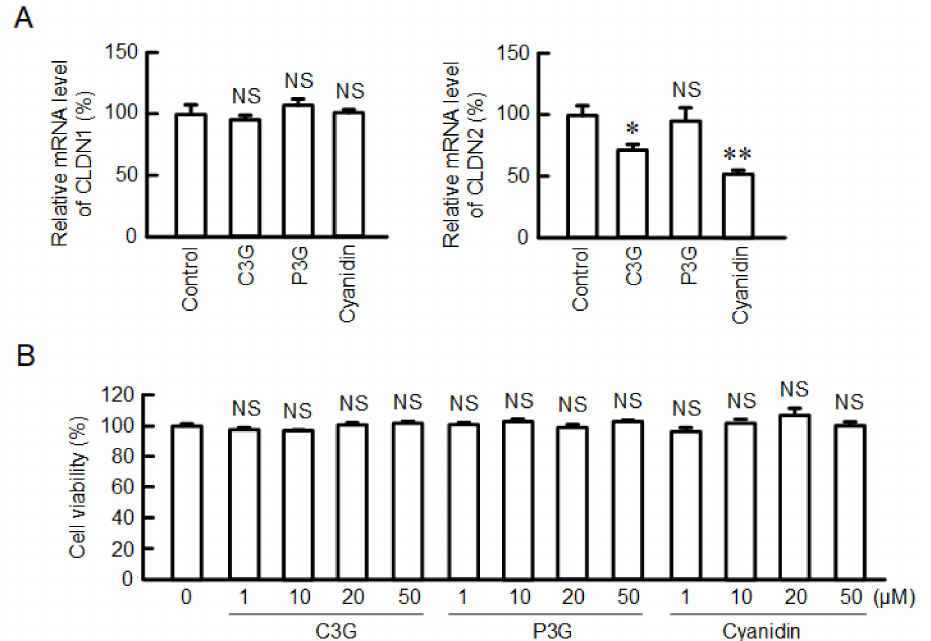
Figure 3. Effects of anthocyanins on the viability and mRNA levels of CLDN1 and CLDN2 . ( A ) Cells were incubated in the absence (control) and presence of 50 µ M anthocyanins for 6 h. The mRNA levels were measured by quantitative real-time PCR and represented as a percentage relative to control. ( B ) Cells were incubated with 0, 1, 10, 20, or 50 µ M anthocyanins for 24 h, followed by the cell viability assays. n = 4. ** p < 0.01, * p < 0.05 and NS p > 0.05 compared with control or 0 µ